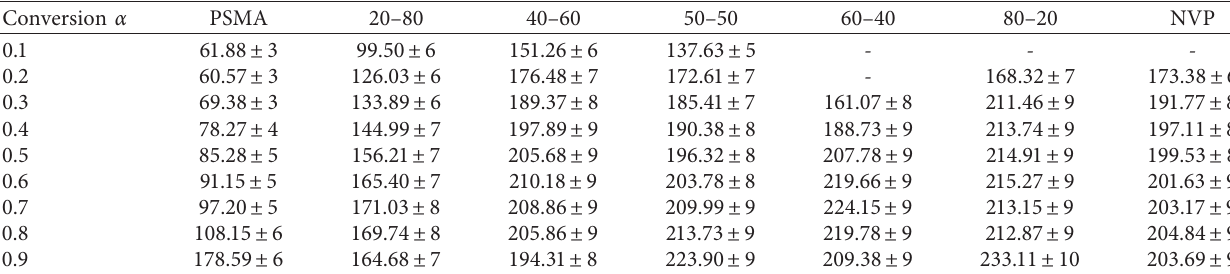
Table 3: Activation energies (KJ) by the OWF method for the PNVP- co -PSMA copolymers.